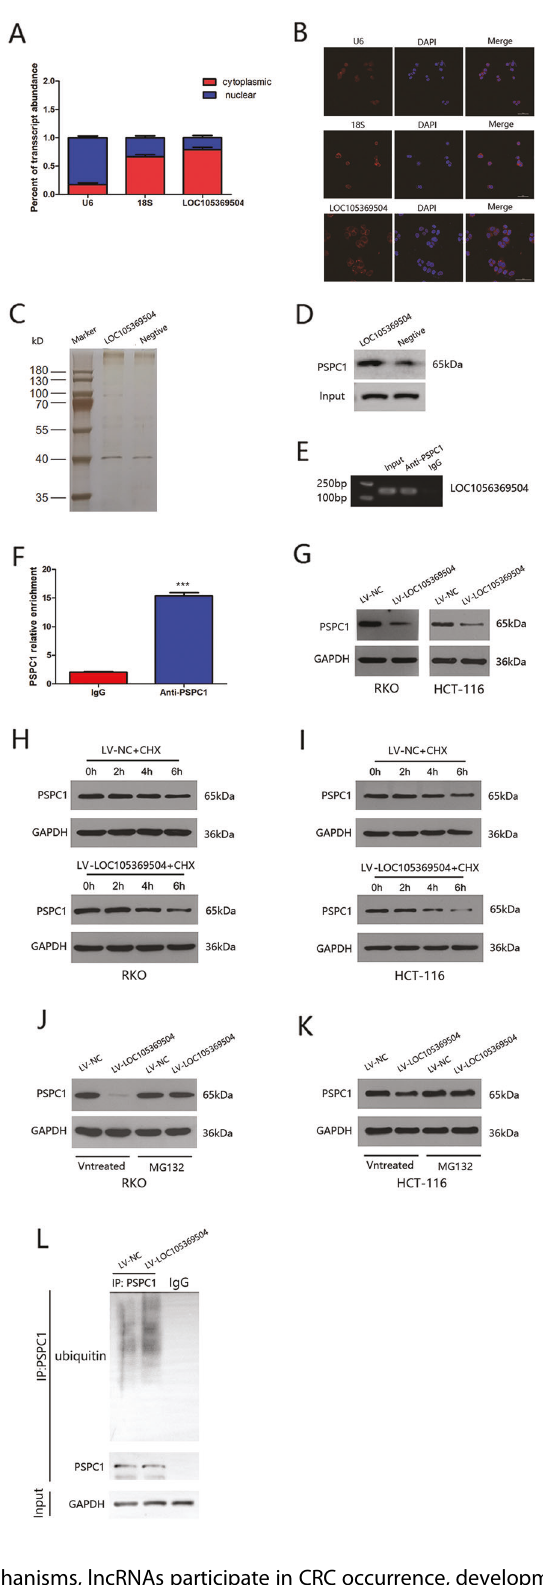
Fig. 3 LOC105369504 decreases the stability of PSPC1 by the ubiquitin-proteasome pathway. A Cytoplasmic and nuclear RNA fractions were separated from RKO cells and the results showed that LOC105369504 was located in the cytoplasm. B FISH was implemented for further con fi rming that LOC105369504 was located in the cytoplasm. C , D RNA pull-down assays after silver staining and western blotting to identify the protein expression of PSPC1 in RKO cells. E , F RIP assay for PSPC1 followed by agarose gel electrophoresis and qRT-PCR suggested that LOC105369504 could bind PSPC1 protein. G In CRC cells, the PSPC1 expression with or without overexpression of LOC105369504 was identi fi ed by western blotting. H , I Western blotting showing the protein level of PSPC1 after treating the cells with CHX (50 μ g/mL). J , K Western blotting displaying the protein level of PSPC1 after treating cells with or without MG132 (10 μ mol/mMl). L Western blot analysis of ubiqui- tinated PSPC1 immunoprecipitated from RKO cells with or without overexpression of LOC105369504. MG132 (10 μ mol/Ml) was utilized to treat cells to suppress the proteasome. All the data are described as mean ± SD. *** p <